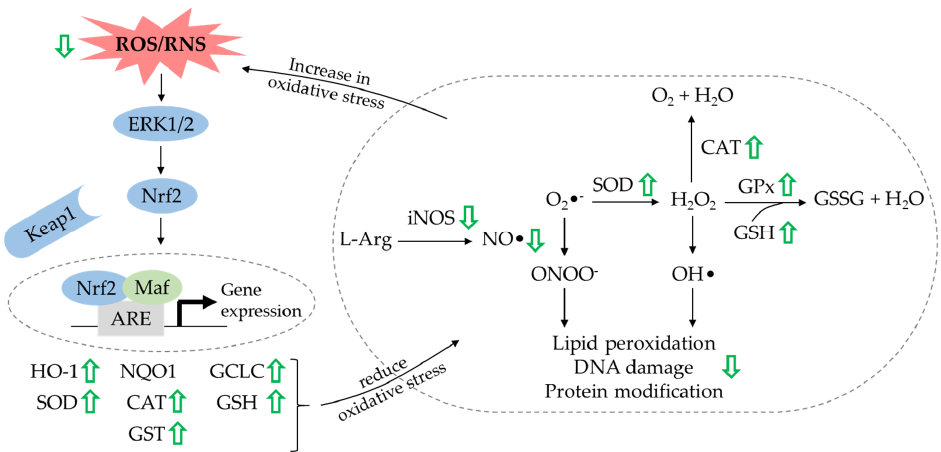
Figure 4. The effects of quercetin on the regulation of oxidative stress in protecting bone. Quercetin decreases oxidative stress and upregulates the expression of antioxidants in osteoblasts and osteoclasts (indicated by the green arrows). Abbreviations: ARE = antioxidant responsive element; CAT = catalase; ERK = extracellular signal-regulated kinase; GCLC = γ-glutamyl-cysteine ligase catalytic subunit; GPx = glutathione peroxidase; GSH = reduced glutathione; GST = glutathione-S-transferase; H 2 O = water molecule; H = hydrogen peroxide; HO-1 = heme-oxygenase 1; iNOS = inducible nitric 2 O 2 oxide synthase; Keap1 = Kelch-like ECH-associated protein 1; Maf = Musculoaponeurotic fibrosarcoma oncogene homolog; NO • = nitric oxide; O 2 = oxygen molecule; O 2 • − = superoxide anions; OH • = hydroxyl radicals; ONOO − = peroxynitrite anion; NQO1 = nicotinamide adenine dinucleotide phosphate quinone dehydrogenase 1; Nrf2 = nuclear factor erythroid 2-related factor-2; ROS = reactive oxygen species; RNS = reactive nitrogen species; SOD = superoxide